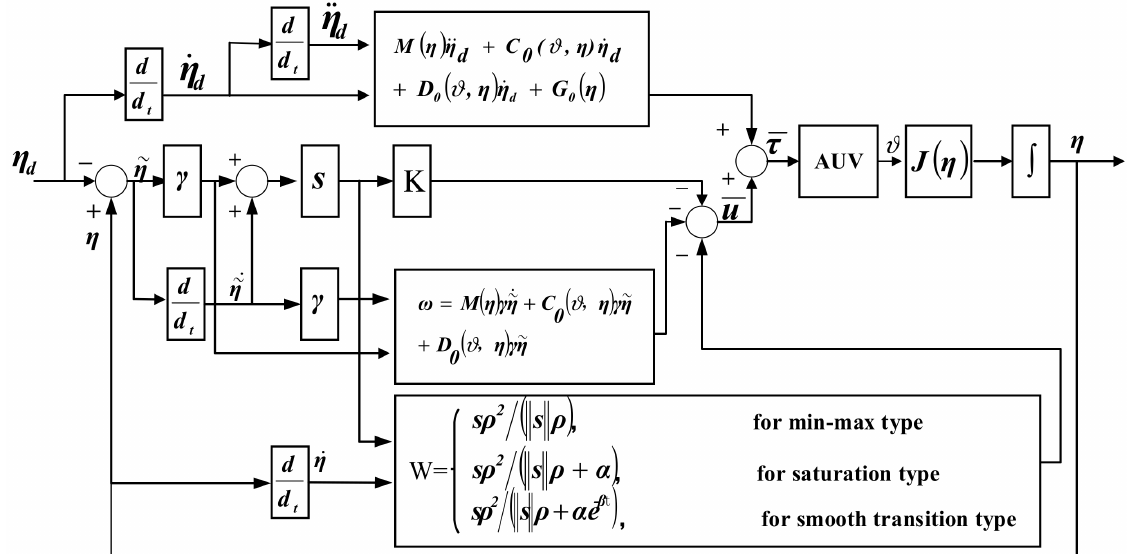
Figure 9. Block diagram of the three proposed exponentially convergent robust controllers (Reprinted from reference [23] with permission from Elsevier, copyright